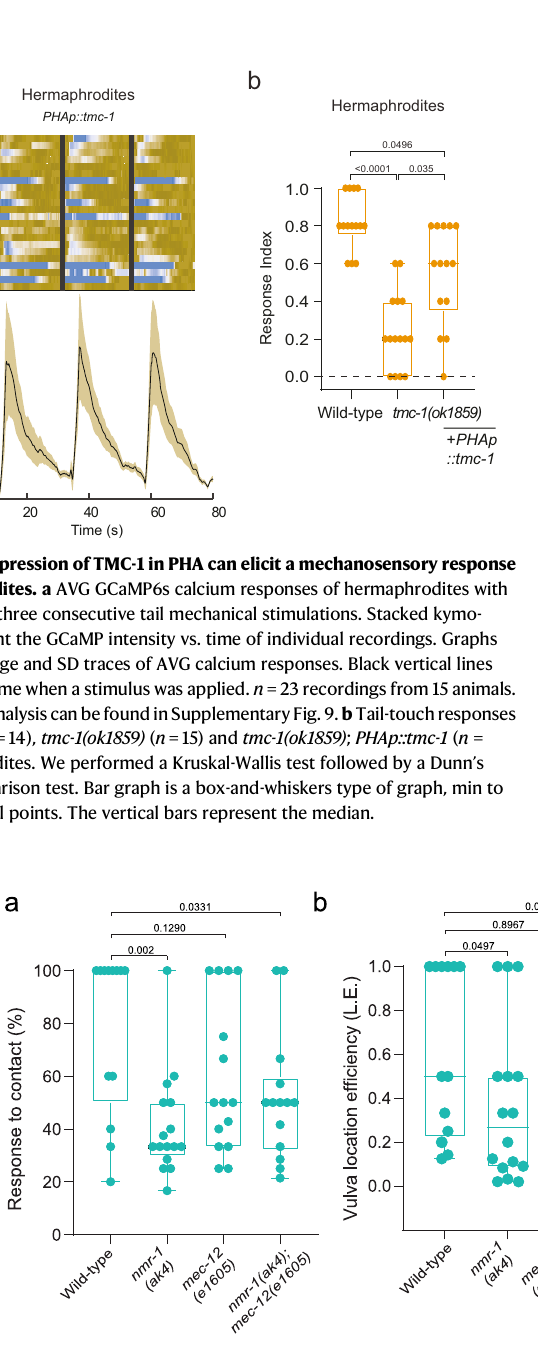
the time until successful mating. in wild-type ( n =13) nmr-1(ak4) ( n =12), mec- 12(e1605) ( n =15)and nmr-1(ak4);mec-12(e1605) ( n =11)males.Weperformedatwo- sided Mann-Whitney test for each comparison. All Bar graphs are a box-and- whiskerstypeof graph, min to max showing allpoints. The vertical bars represent the